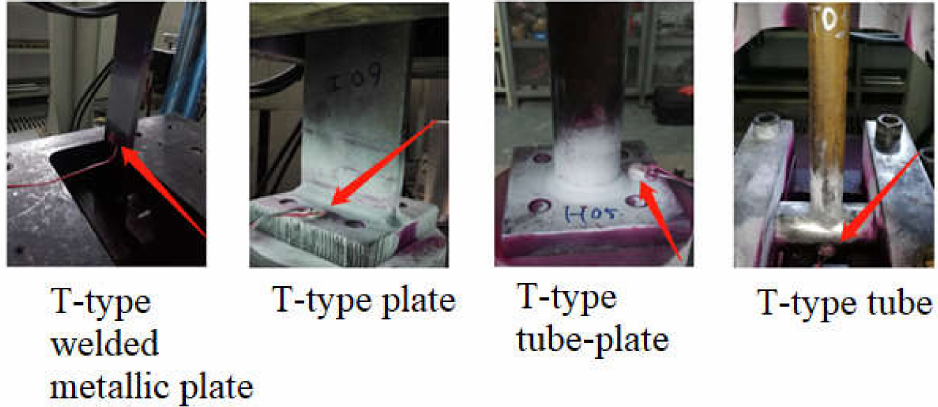
Figure 5. PZT transducers mounted on the